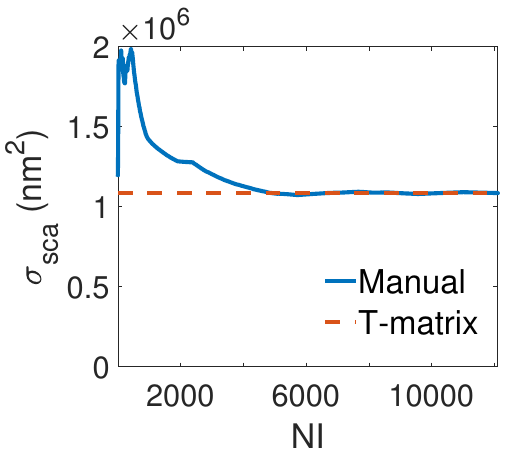
Figure 3. Convergence of scattering cross section with respect to the number of illumination of the gold nanospheres arranged in a helix for the wavelength of 730 nm. The brown dashed lines denote the value extracted directly from the T-matrix while the blue straight lines denote the value obtained from averaging method for different number of illumination